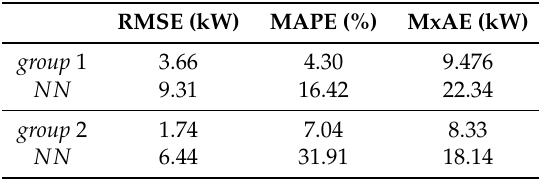
Table 4. Comparison of forecasting results in NN.